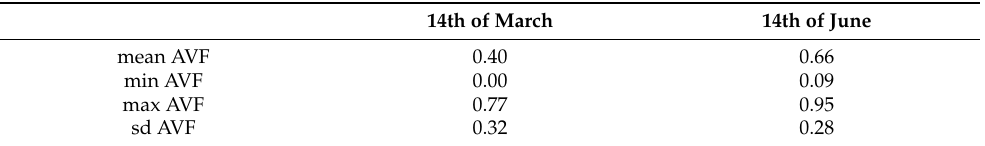
Figure 6. Spatial average of the sunlit area of all urban trees in Rieselfeld for 14th of March (green) and 14th of June (orange) on a hourly basis under clear sky conditions. The maximum in June is of greater magnitude than in March. The trees receive sunlight earlier in the morning and longer in the evening during summer. Table 2. Statistics of the averaged area view factor of urban trees for 14 June and 14 March (from 04:00 to 19:00 UTC) in Freiburg-Rieselfeld,